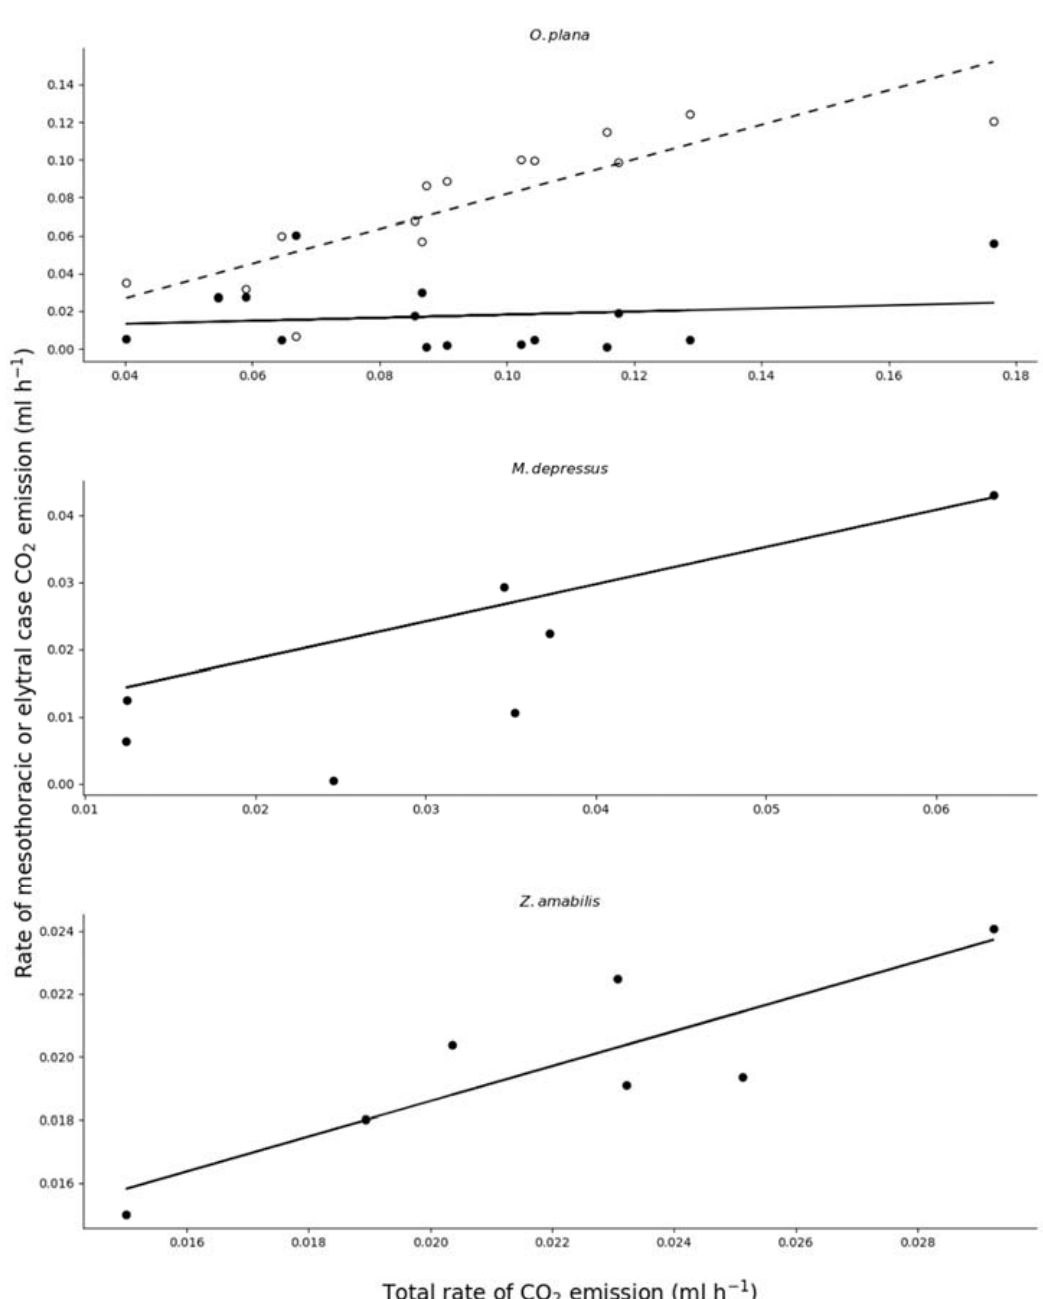
Figure 1. Comparison of the CO 2 emission rates from the mesothoracic spiracles ( • ) as a function of total CO 2 emitted for three Namib Desert tenebrionid beetles. Only O. plana has the CO 2 emission rate from the elytral case ( ○ ) as a function of total CO 2 emitted as the other two species had two or more individuals in which there was no CO 2 emitted through the elytral case. The regression equation for each species is given where m = mesothoracic spiracle V total CO2 . For O. plana : m = 0.01 + 0.69 t , r 2 = 0.14, p = 0.6; el = − 0.01 + 0.92 t , r 2 = 0.85, p < 0.0001. For M. depressus : m = − 0.004 + 0.69 t , r 2 = 0.83, p = 0.022. For Z. amabilis : m = 0.007 + 0.56 t , r 2 = 0.86, p = 0.014.